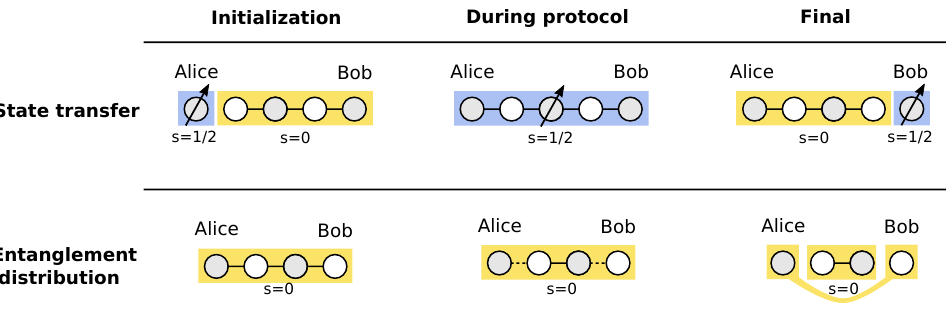
Figure 1: A sketch of the intuition behind our results. In the state transfer protocol, Alice initializes a spinful state while the rest of the system has zero total spin. The whole system then exhibits the same spin properties as the initialized state. After an appropriate adiabatic trajectory, Bob becomes disconnected. If the remainder of the system has a spin-zero ground state, then Bob’s site must contain all spin information. Similarly, in entanglement distribution, Alice and Bob start with a state with zero total spin. After they disconnect, if the remainder of the system has total spin zero, then they must also share a total spin zero